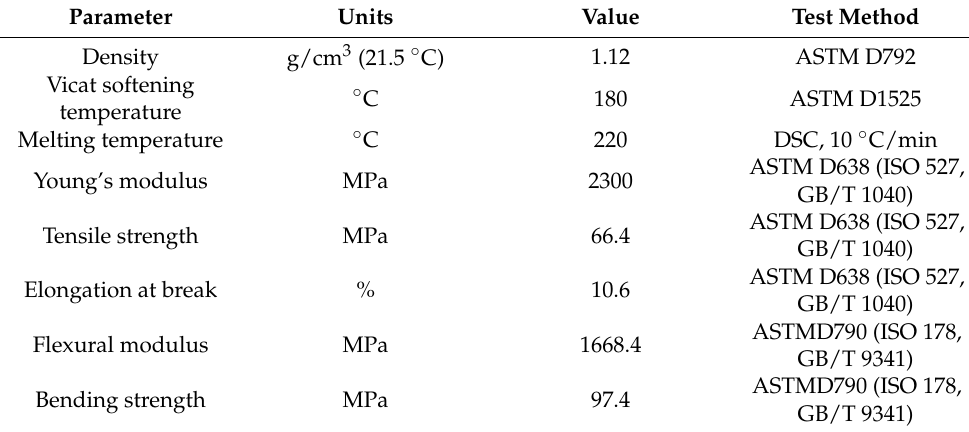
Table 3. Technical performance of nylon 6/66